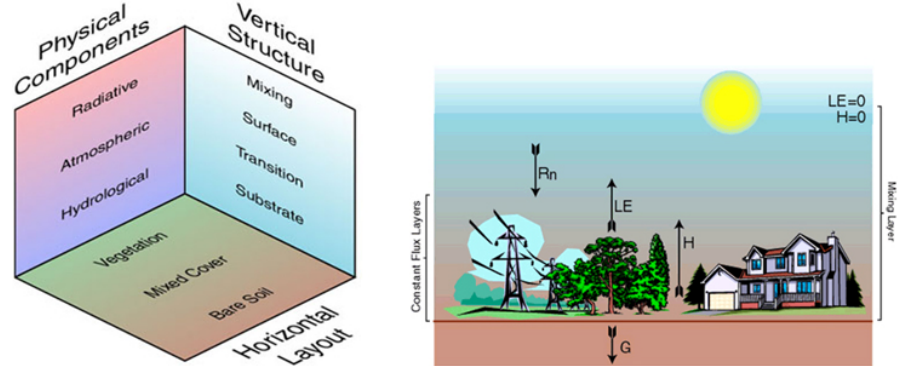
Figure 1. Left: the different layers of the SVAT model in the vertical domain; right: a schematic representation of the surface energy balance components computation in the SVAT model (after SimSphere user’s manual available at http://www.aber.ac.uk/en/iges/research-groups/